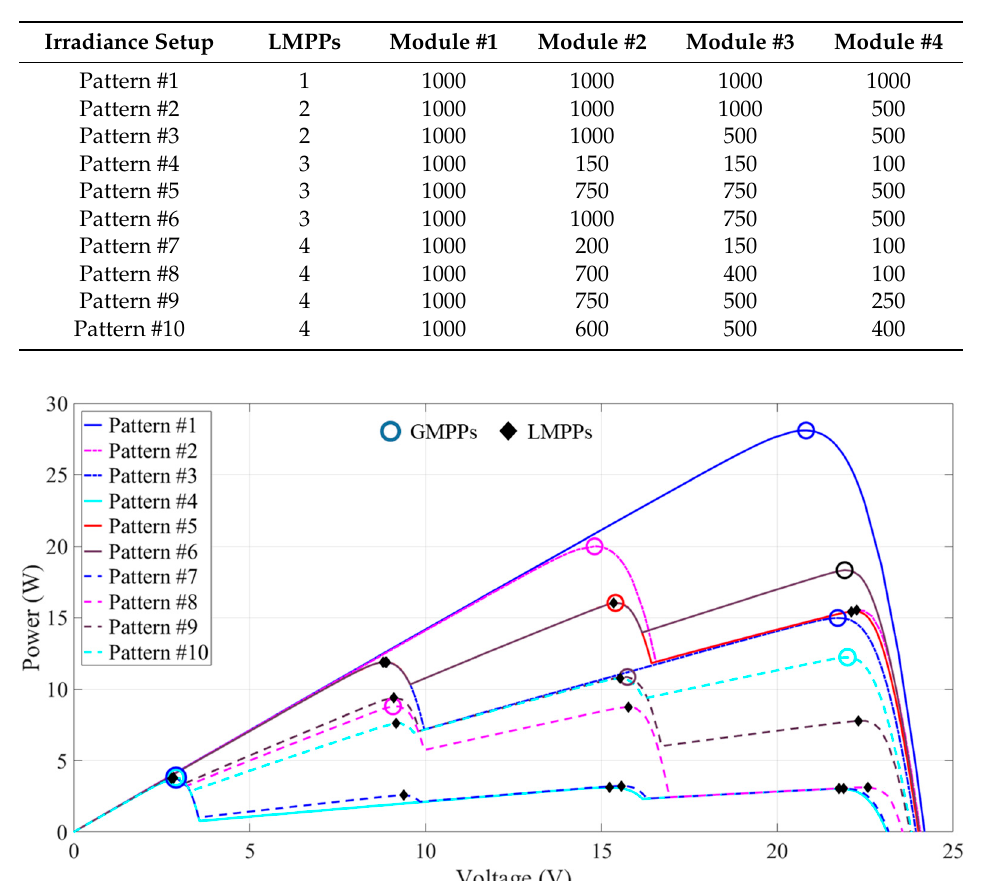
Figure 12. P - V curves of the 10 PSC patterns in the simulation.